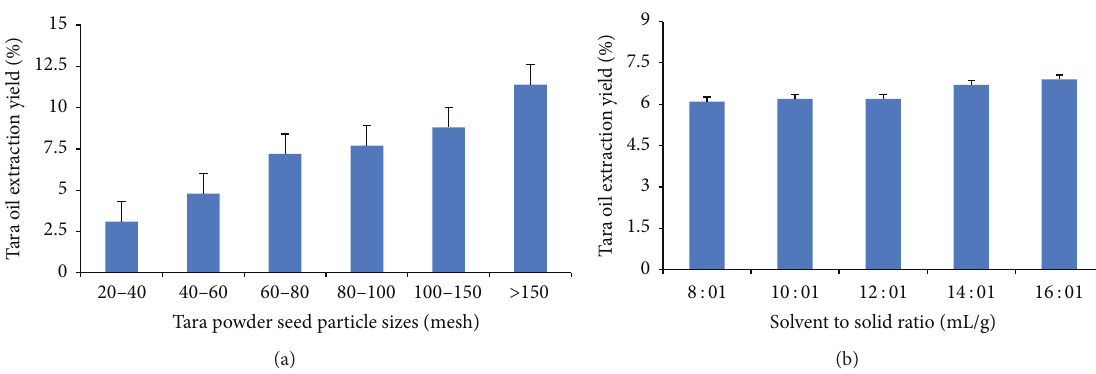
Figure 2: (a) Tara seed oil yields with different particle sizes. Samples of dried tara powder (10g) ground to different sizes (20–40, 40–60, 60–80, 80–150, and > 150 mesh) were extracted with petroleum ether. Ultrasonic extraction was performed for 45 min at 250 W and 30 ∘ C. (b) Tara seed oil yields with different liquid–solid ratios. Dry tara powder (10g, 60–80 mesh) was extracted with different liquid–solid ratios